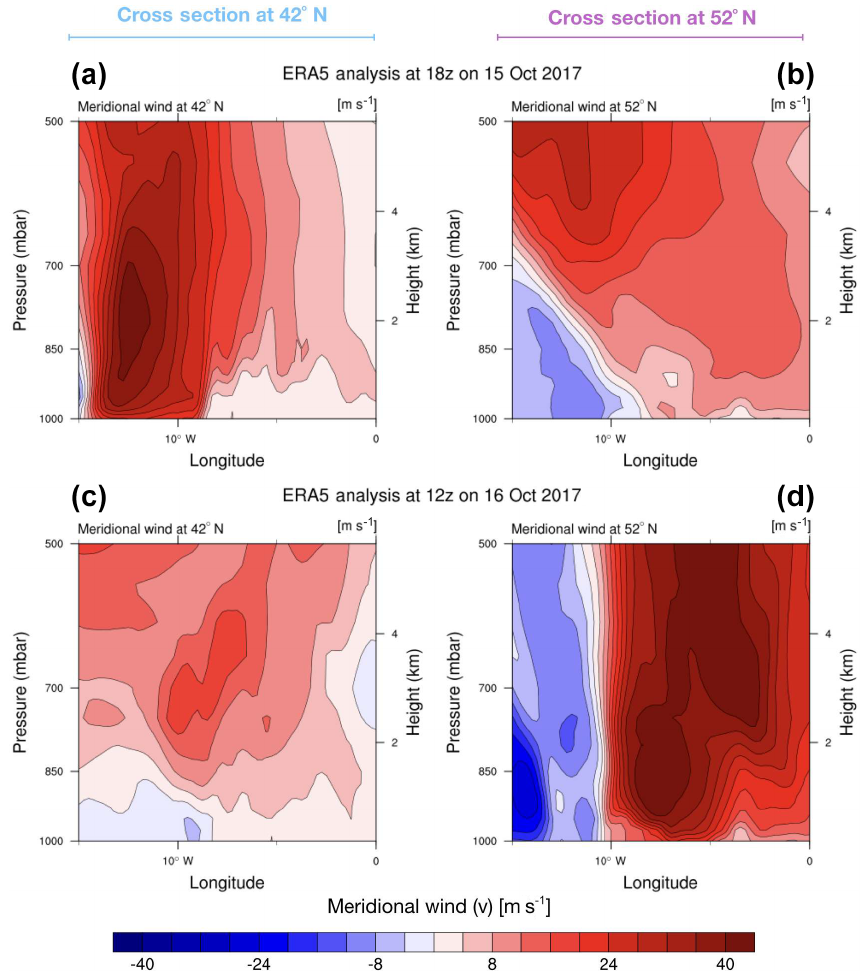
Figure 4. Vertical cross sections of the meridional wind from ERA5 taken at latitudes of 42 ◦ N (a, c) and 52 ◦ N (b, d) for 15 October at 18:00UTC (a) and for 16 October at 12:00UTC (b) . Red represents transport to the north, while represents blue transport to the